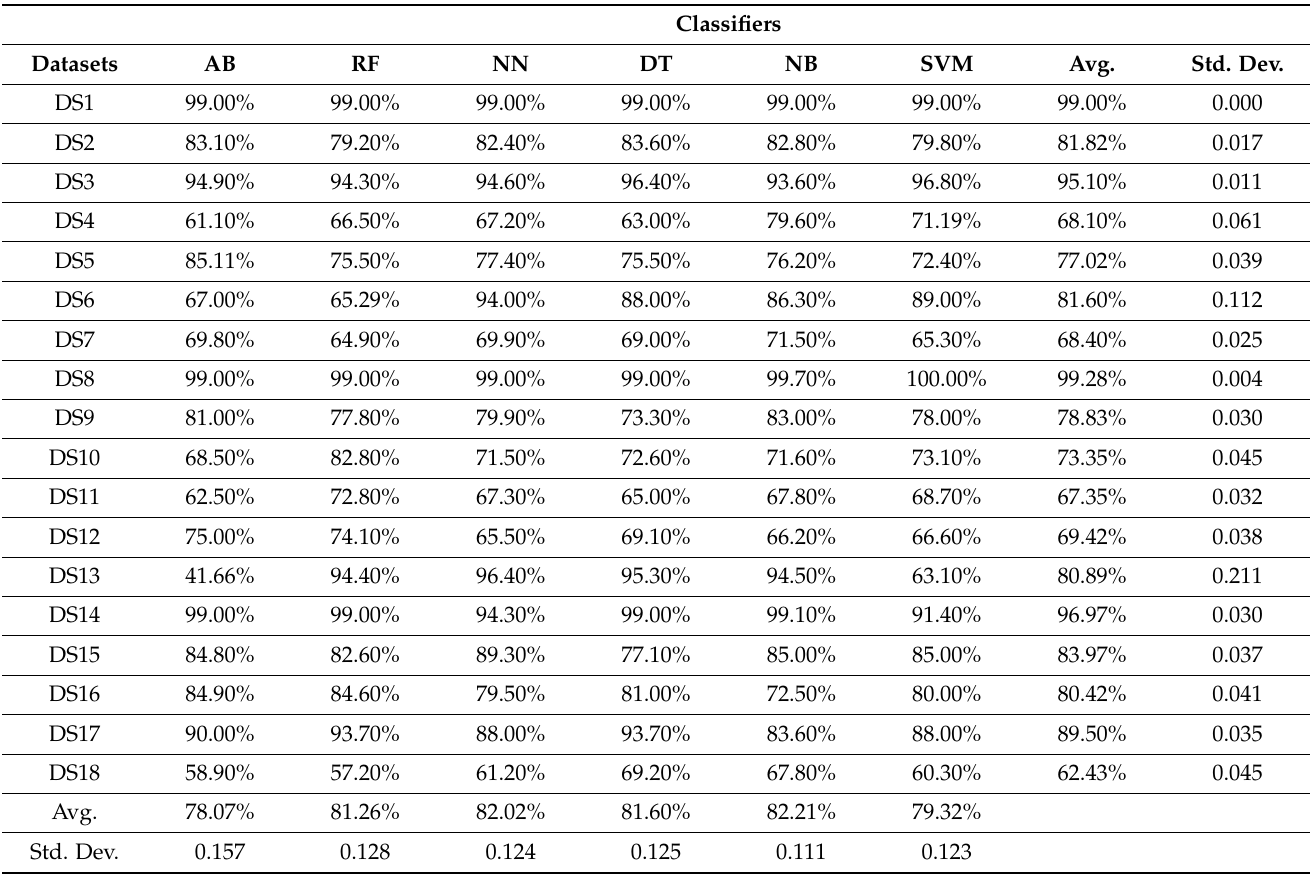
Table A1. Precision of classifiers trained on small